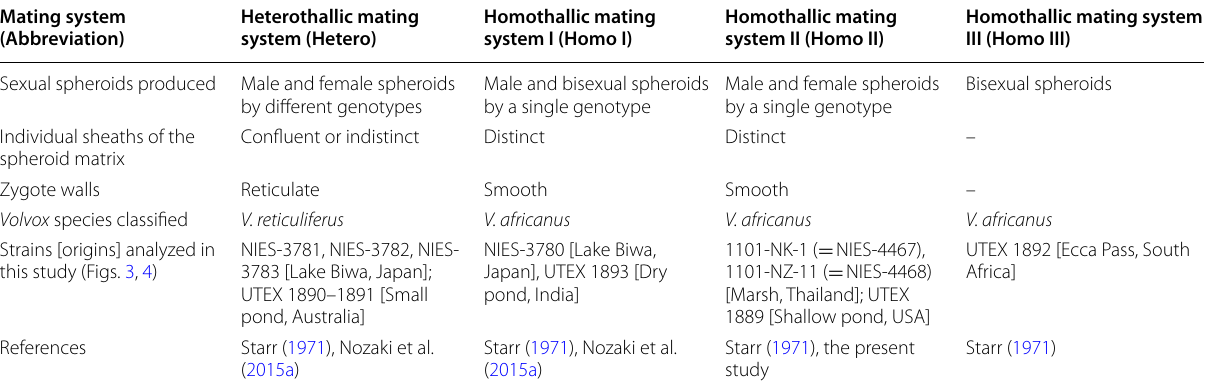
UTEX 1893, 1889 and 1892 have been deceased and lack information of individual sheaths and zygote morphology (Nozaki et al.